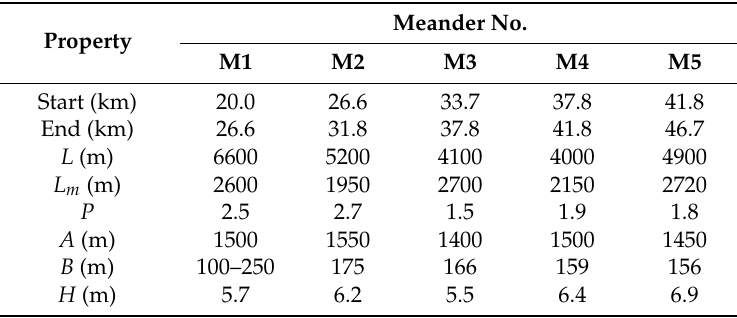
Table A1. Characteristic values of geometrical properties of meanders (M) shown in Figure 1. The streamwise distance was measured using Meng í bar dam as the origin of reference. L =